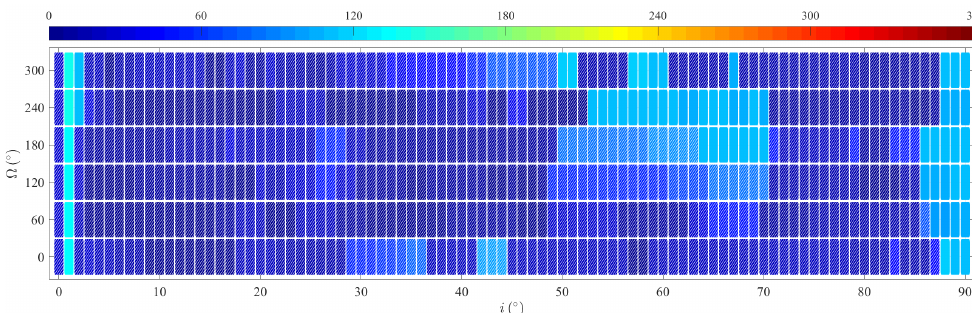
Figure 17. With (cid:107) T (cid:107) = 20 mN, the lifetime of spacecraft in the 20 km-altitude near-circular orbit. Adjusting the semi-major axis to a = 1748 km, i.e., a near-circular orbit of about 10 km- altitude, collision can be avoided in most cases with (cid:107) T (cid:107) = 20 mN. the lifetime extension results are shown in Figure 18. In the area where collision is avoided, 10 km-altitude detection can be realized with (cid:107) T (cid:107) = 20 mN. In the other area, detection ought to proceed at a higher altitude or be maintained with larger thrust.